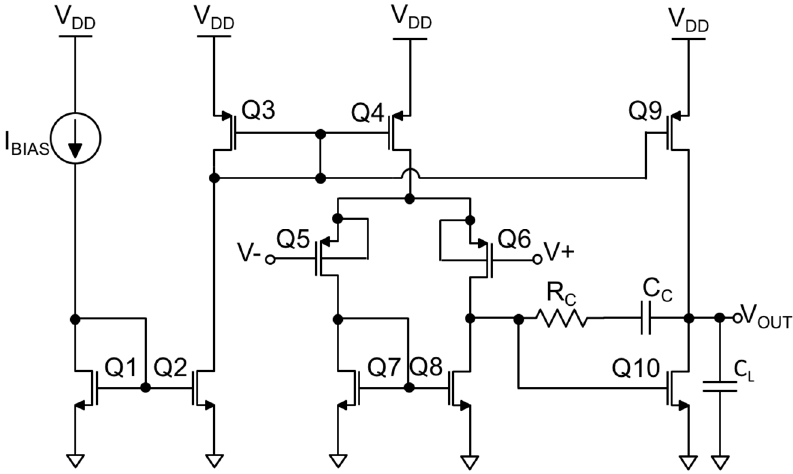
Figure 4. Schematic of the two-stage opamp.